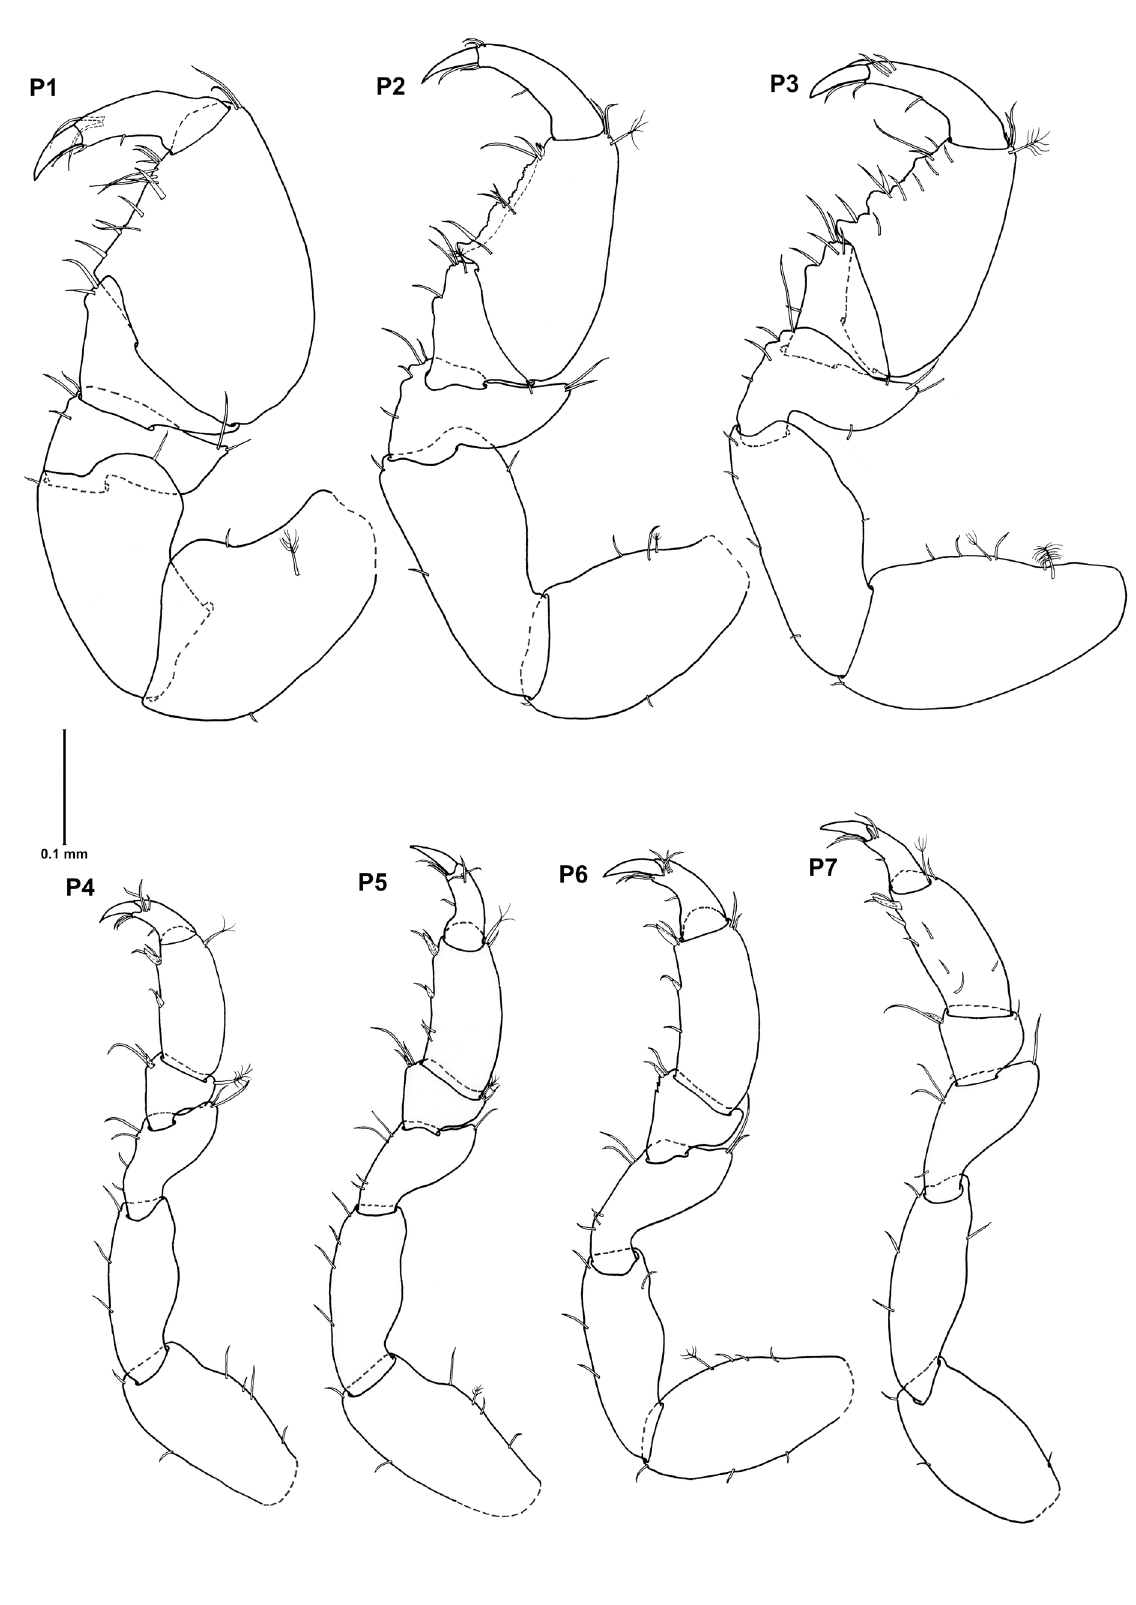
Fig. 25. Expanathura marcoi sp. nov., ♀, holotype (MZB Iso 108) . Abbreviations: P1–P7 = pereopods